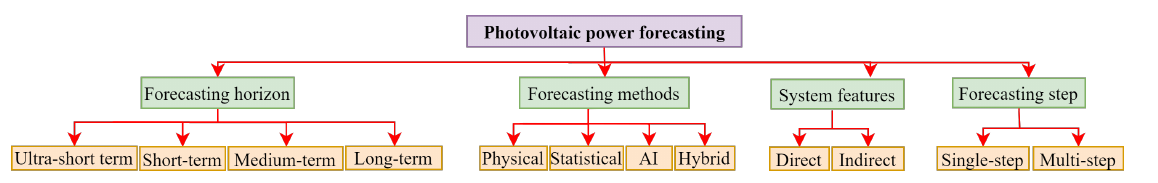
Figure 1. General taxonomy of PV power